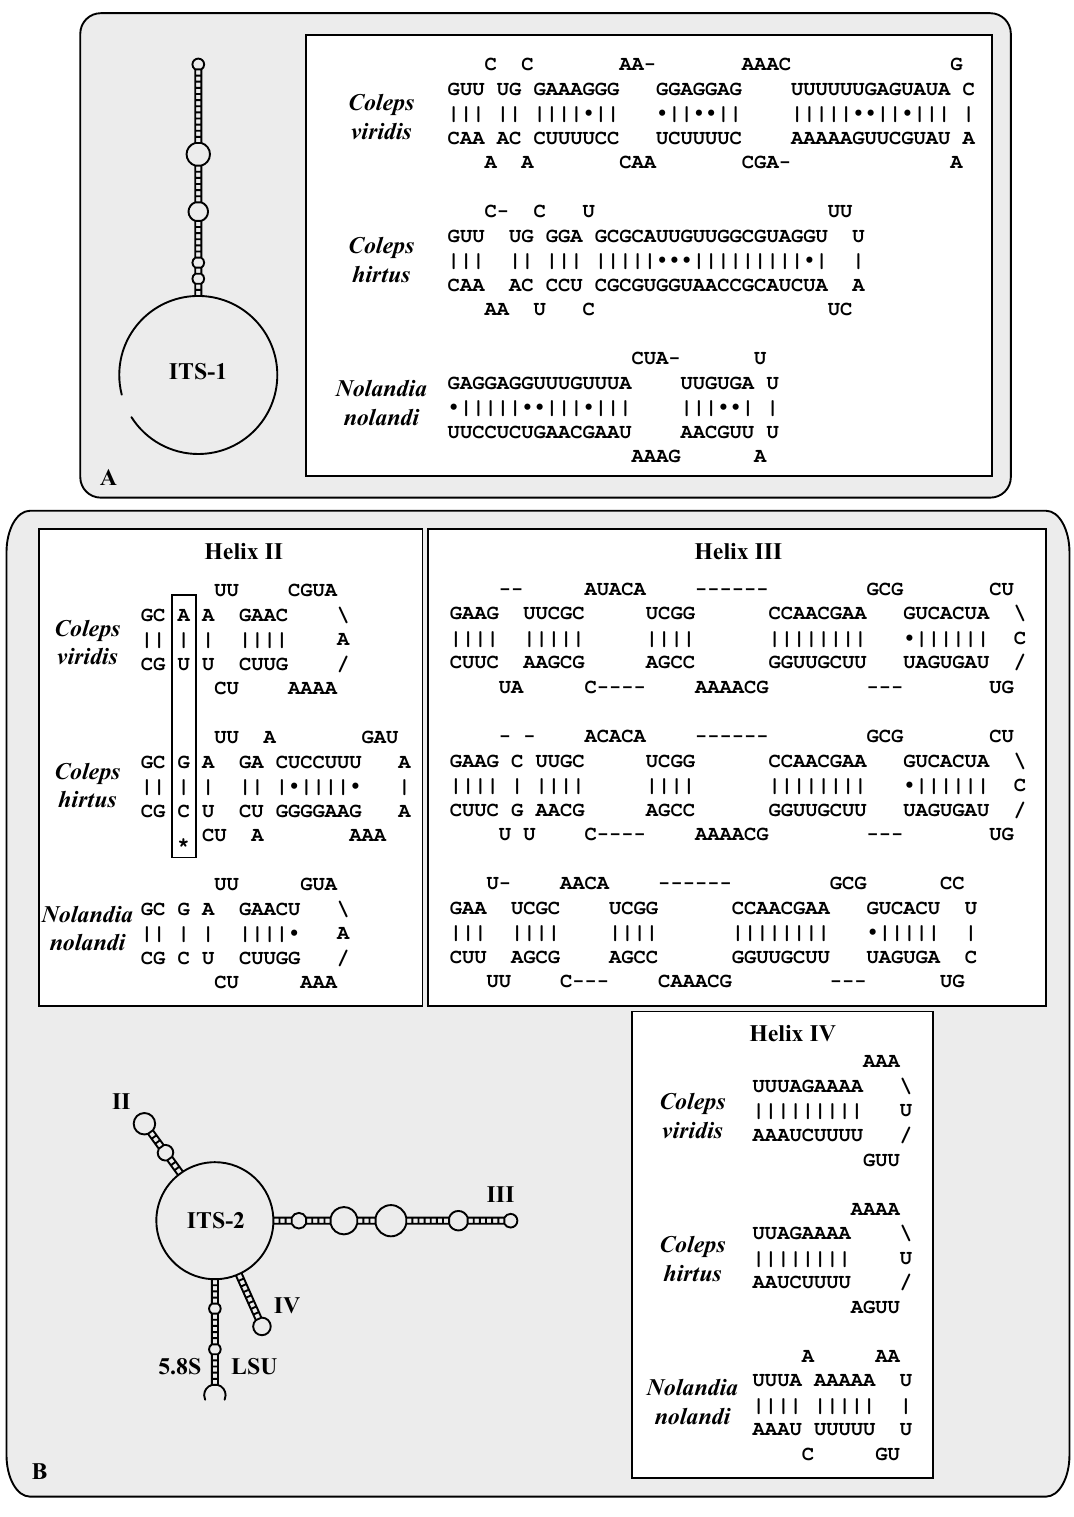
Figure 4. Comparisons of the ITS-1 ( A ) and ITS-2 ( B ) secondary structures among the species of Coleps and Nolandia . The line structures were drawn with PseudoViewer3 41 . The structures of the helices were calculated with mfold 42